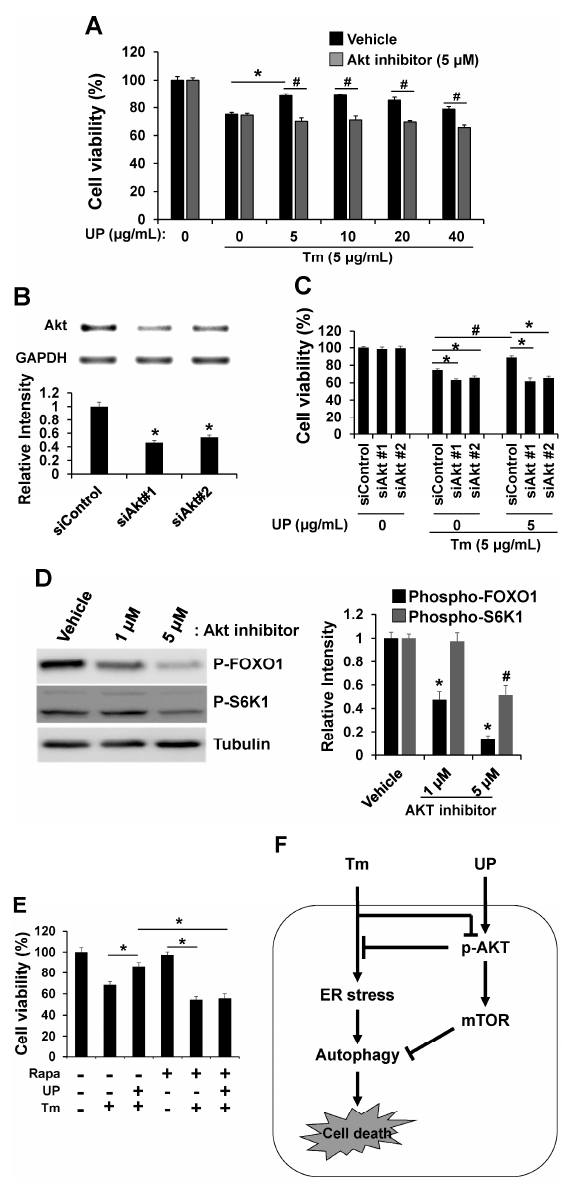
Figure 5. Role of AKT/mTOR signaling in ER stress-induced cytotoxicity. ( A ) GT1-7 cells treated with UP were incubated with tunicamycin (24 h) with or without Akt inhibitor and cell viabilities were then assessed by MTT assay. The results are means ± SDs ( n = 3); * p values of <0.05 indicate significantly different from treatment with UP. # p values of <0.05 indicate significantly different from treatments without inhibitor; ( B ) Knockdown of Akt was demonstrated by RT-PCR analysis. Densitometric analysis results are also shown ( lower ). GAPDH was used as a control. * p values of <0.05 indicate significantly different from control siRNA; ( C ) Expression of Akt in GT1-7 cells was knockdowned using siRNAs against Akt. GT1-7 cells were treated with tunicamycin (5 μ g/mL) with or without UP (5 μ g/mL) for 24 h, and cell viabilities were measured with MTT assay. The results shown are means ± SDs ( n = 3). * p values of <0.05 indicate significantly different from control siRNA. # p values of <0.05 indicate significant differences from treatments without UP; ( D ) The levels of phospho-FOXO1 and phospho-p70S6K1 were measured after treatment with Akt inhibitor by Western blotting. Tubulin was detected as a loading control. Densitometric analysis results ( right ) are also shown; ( E ) GT1-7 cells treating UP were incubated with tunicamycin (24 h) with or without rapamycin, mTOR inhibitor, and cell viabilities were assessed by MTT assay. The results are means ± SD ( n = 3); * p values of <0.05 indicate significant differences between the conditions indicated; ( F ) Hypothetical model depicting a central role of UP in ER stress-induced cell death.